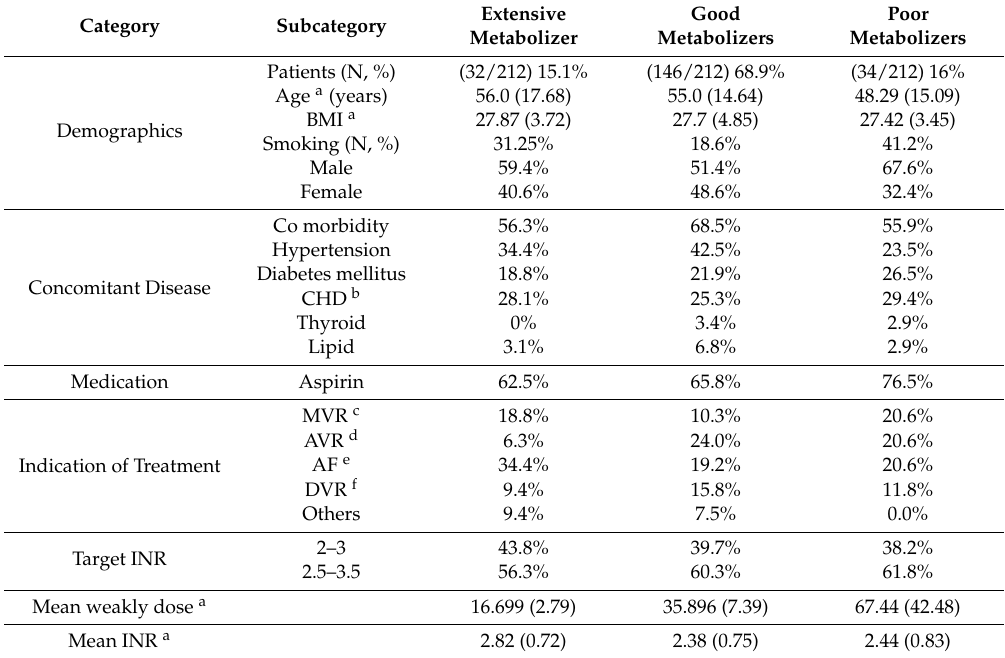
Table 1. Descriptive analysis of demographics and clinical characteristics of 212 cardiovascular patients treated with warfarin at the Queen Alia Heart Institute.